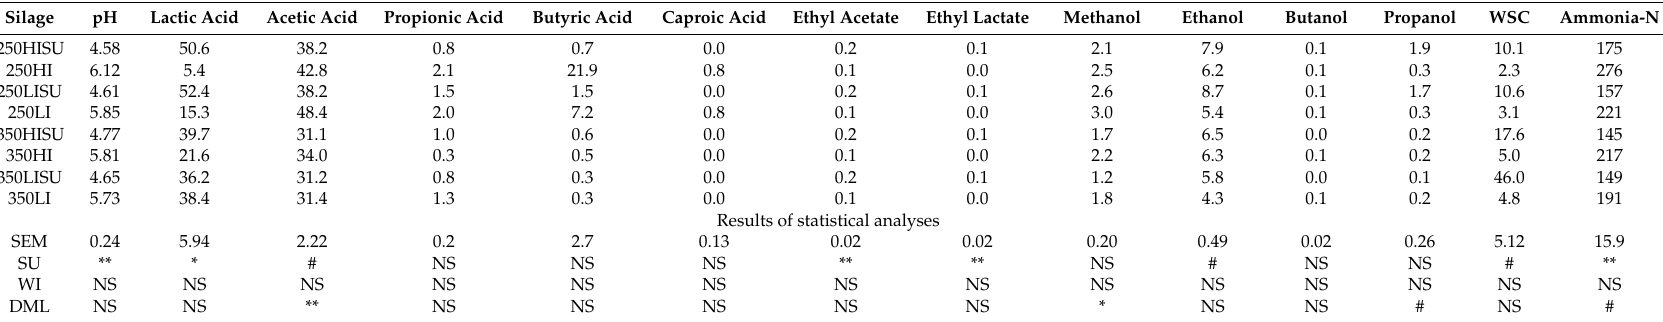
Table 6. Effect of sucrose addition (SU), wilting intensity (WI), and DM level (DML) on lactic acid, volatile fatty acids, ester compounds, alcohols,